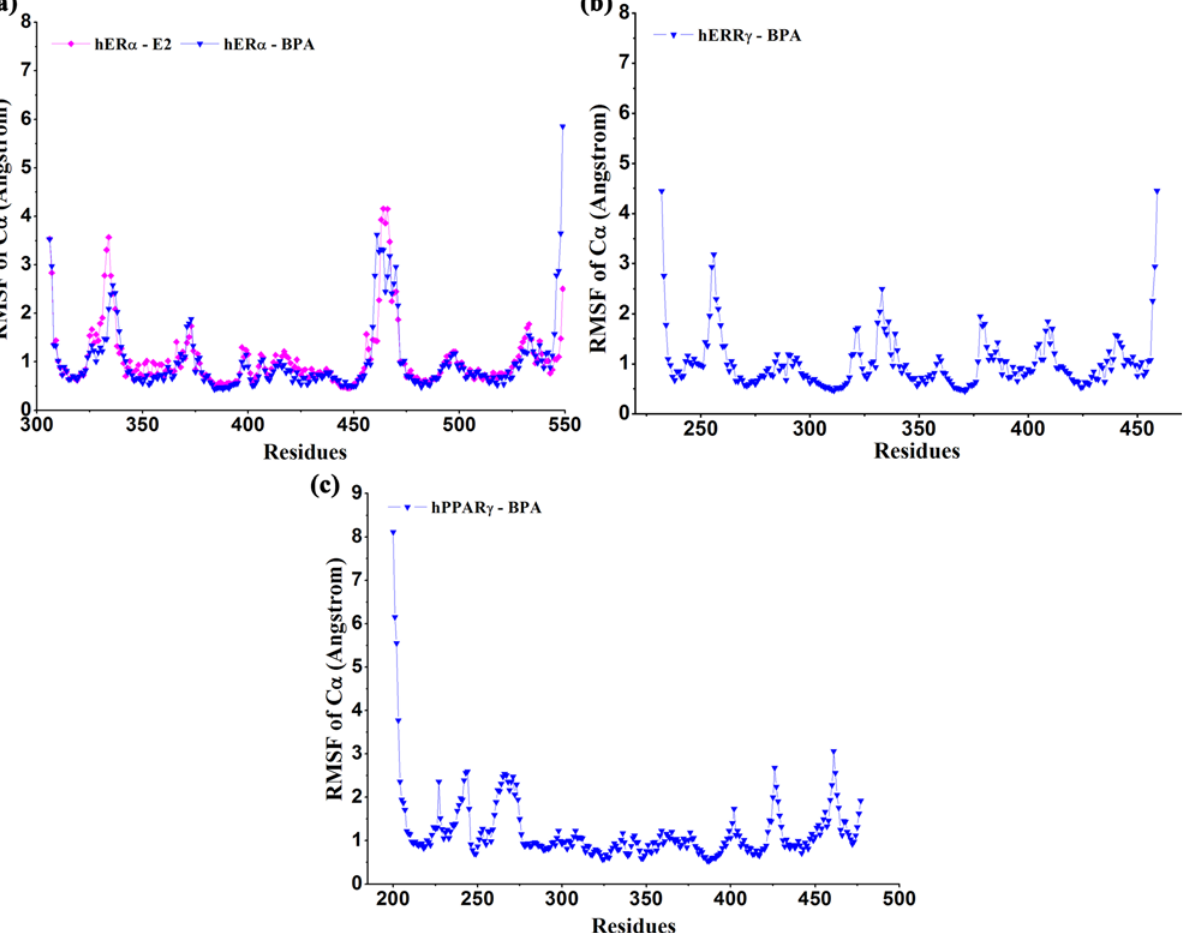
Fig 4. The RMSFs of C α atoms relative to the initial